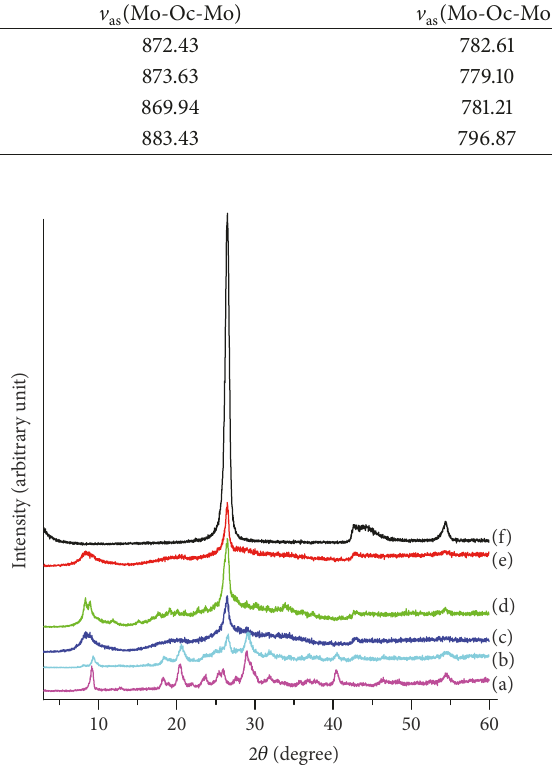
Figure 2: XRD spectra of the functionalized CNTs and CNTs-PMo- 𝑥 series of catalysts. (a) CNTs-FePMo-350; (b) CNTs-FePMo-300; (c)CNTs-FePMo-250;(d)CNTs-FePMo-200;(e)CNTs-FePMo-150; (f) functionalized